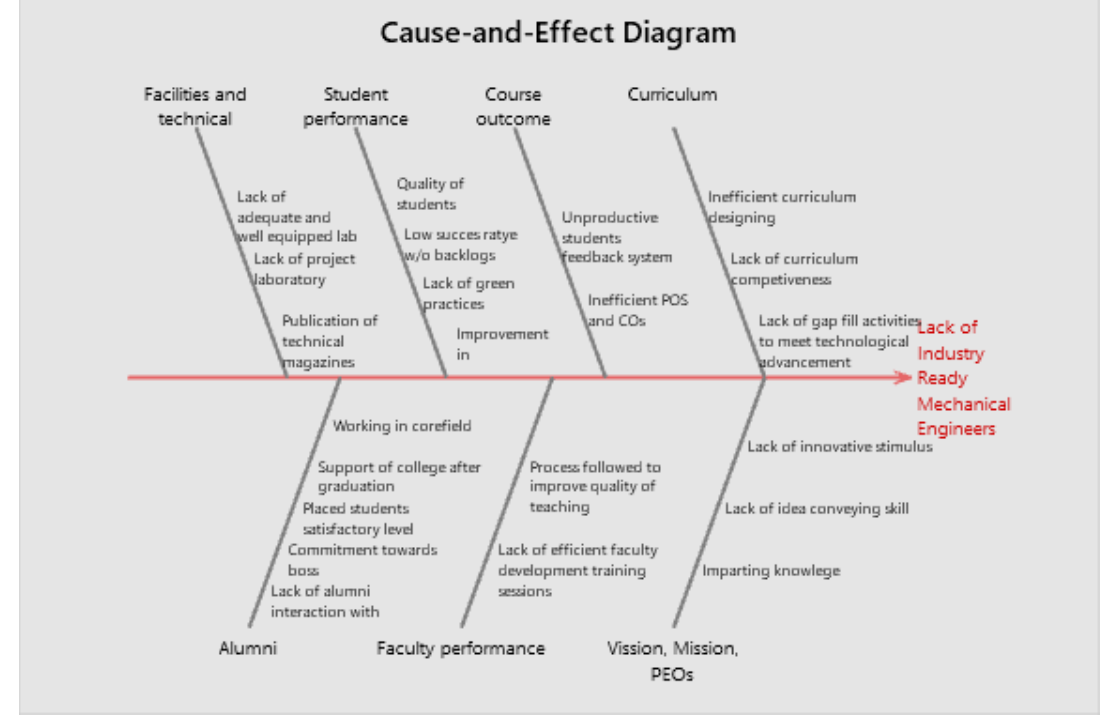
Figure 4. Cause and Effect